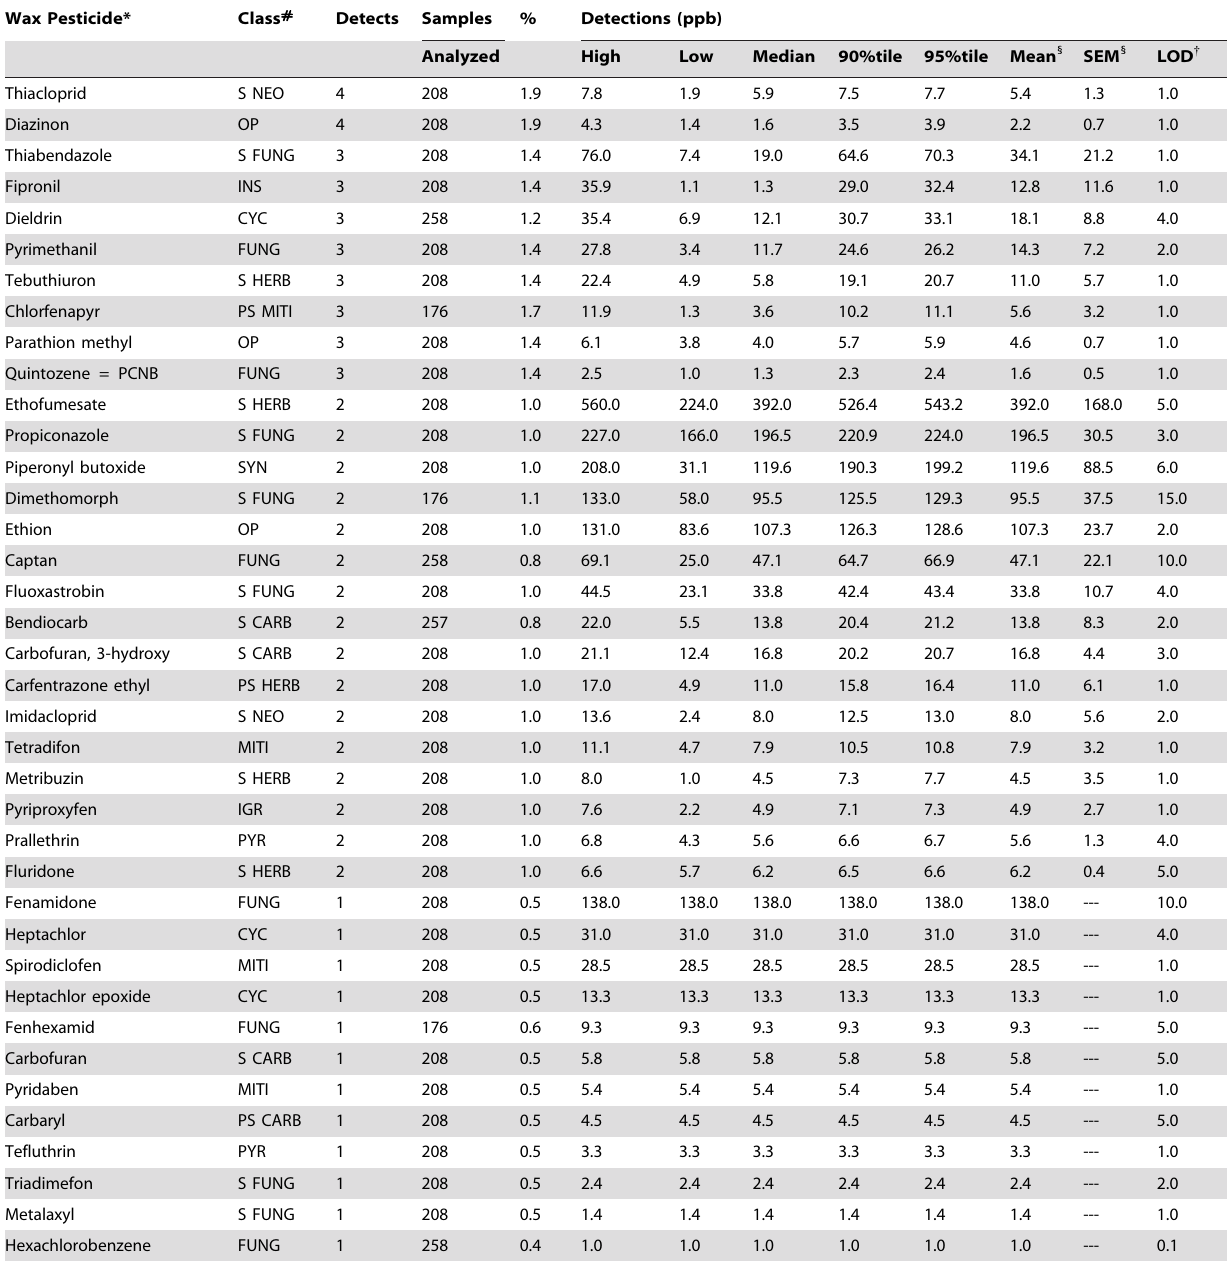
Focused analysis of detections from only the pollen and wax further indicates the high potential of bee exposure to hive pesticide residues. Two or more pesticides were found in 98.4%, three or more in 91%, and four or more in 80% of the 609 samples analyzed. Almost 60% of these pollen and wax samples, in contrast to 10.7% of bee samples, contained at least one systemic